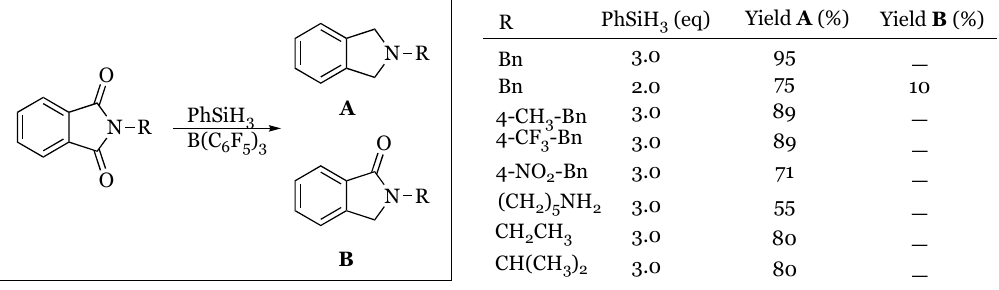
Figure 16. Mild and selective formation of N -substituted pyrrolidines from cyclic imides.